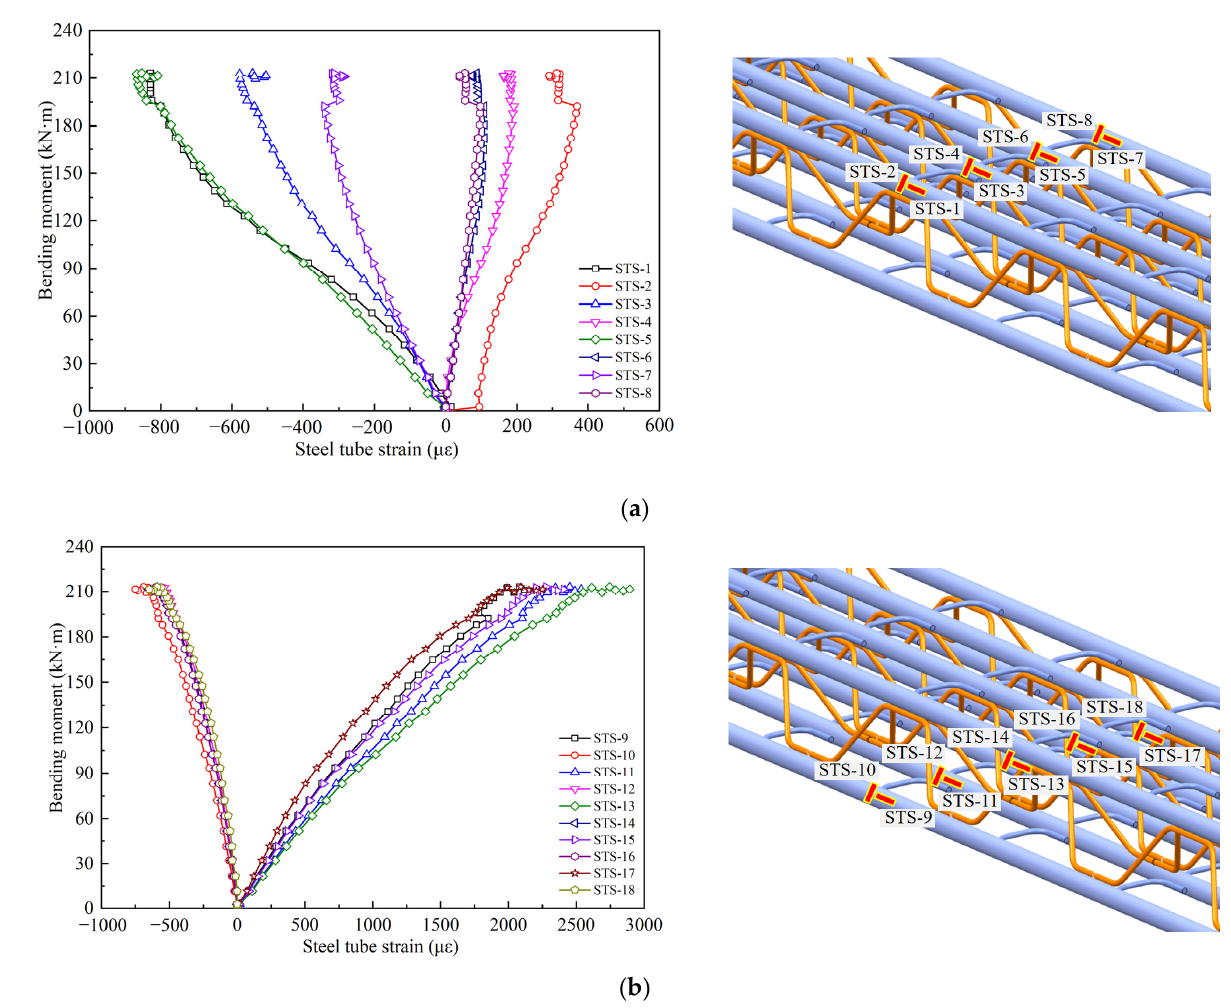
Figure 16. Bending moment–steel tube strain relationship curves of the 1/2 section of the jointless component. ( a ) external steel tubes and ( b ) internal steel tubes.